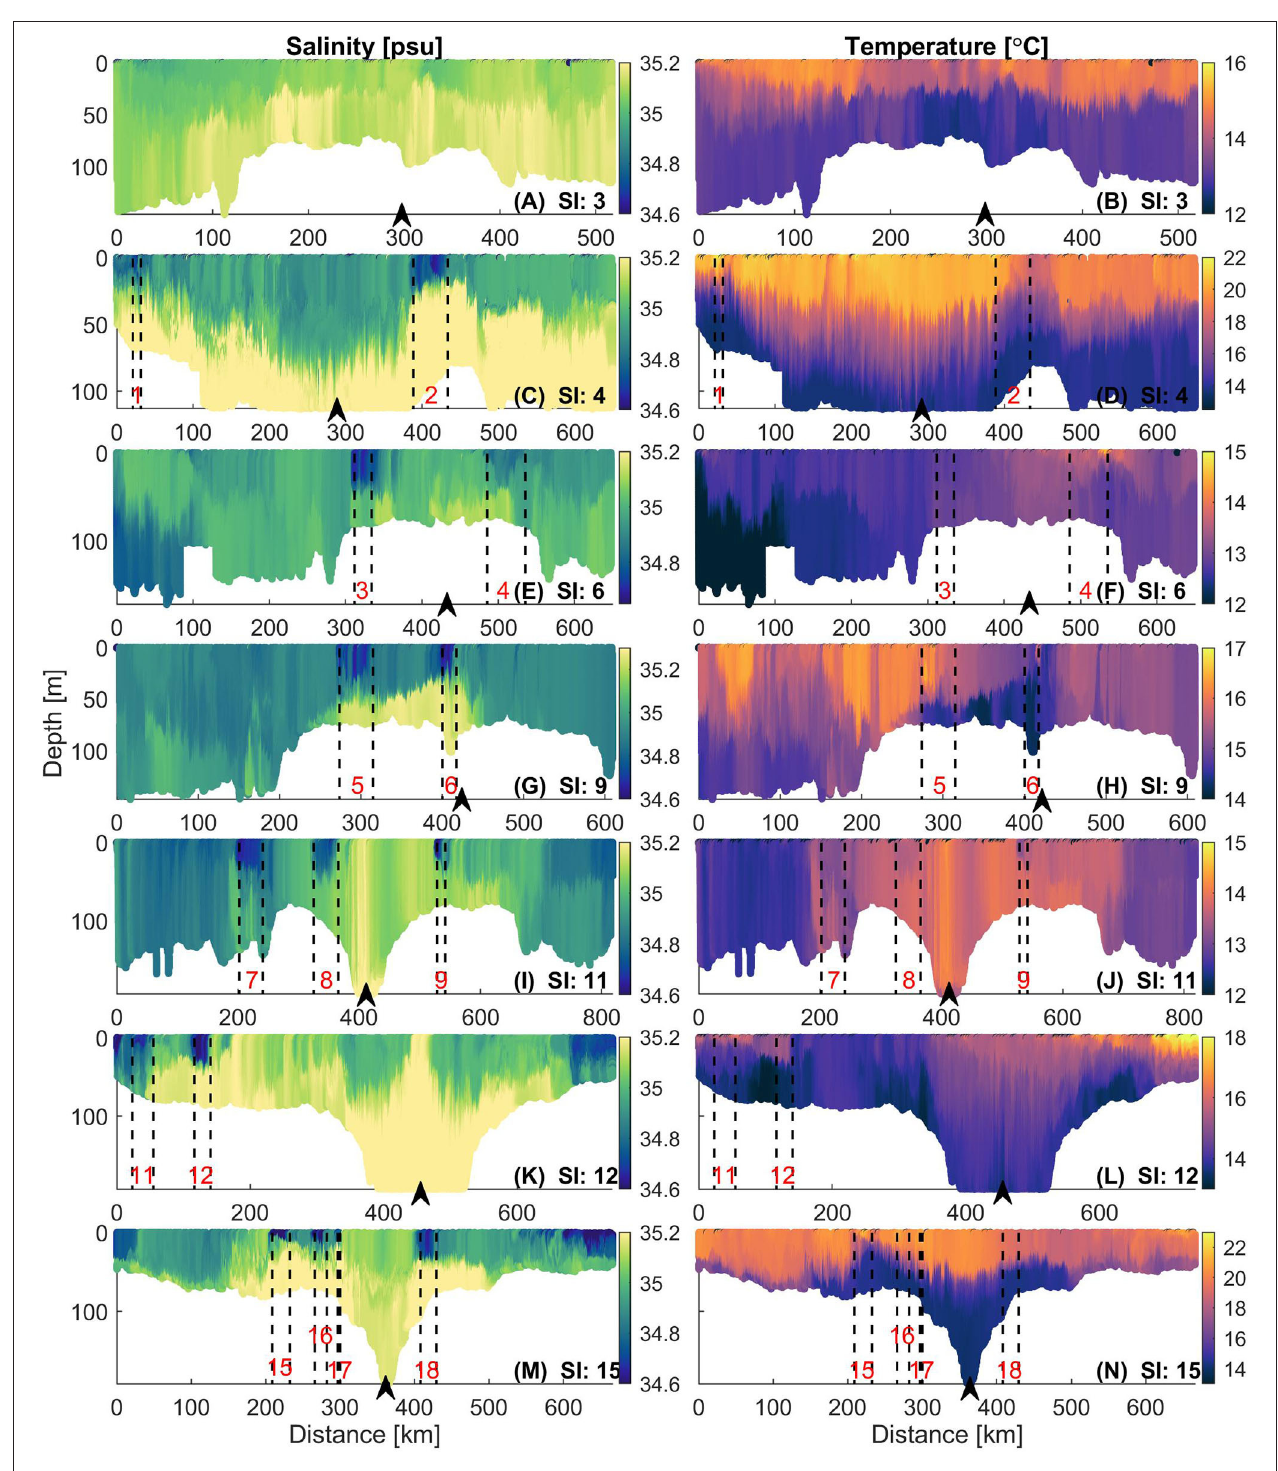
FIGURE 3 | Salinity and temperature transects for seven glider surveys in Greater Cook Strait. SI: Glider Survey Index consistent with Tables 1 , 2 ; (A,B) SI 3, (C,D) SI 4, (E,F) SI 6, (G,H) SI 9, (I,J) SI 11, (K,L) SI 12 and (M,N) SI 15. In each glider survey, the glider goes from east to west and back; black arrow in each transect indicates westernmost turn-around point of glider for each survey. LSMFs observed in Greater Cook Strait, north of Farewell Spit and near Stephen Island (15 out of 22 LSMFs) are highlighted by black dashed lines and numbered in red for each transect. Geographical locations of LSMFs are highlighted in blue circles on Figure 1B . The LSMF numbering is consistent with Table 2 . Note: Colorscales for temperature transects were adjusted to resolve temperature gradients in each survey due to high seasonal variability.